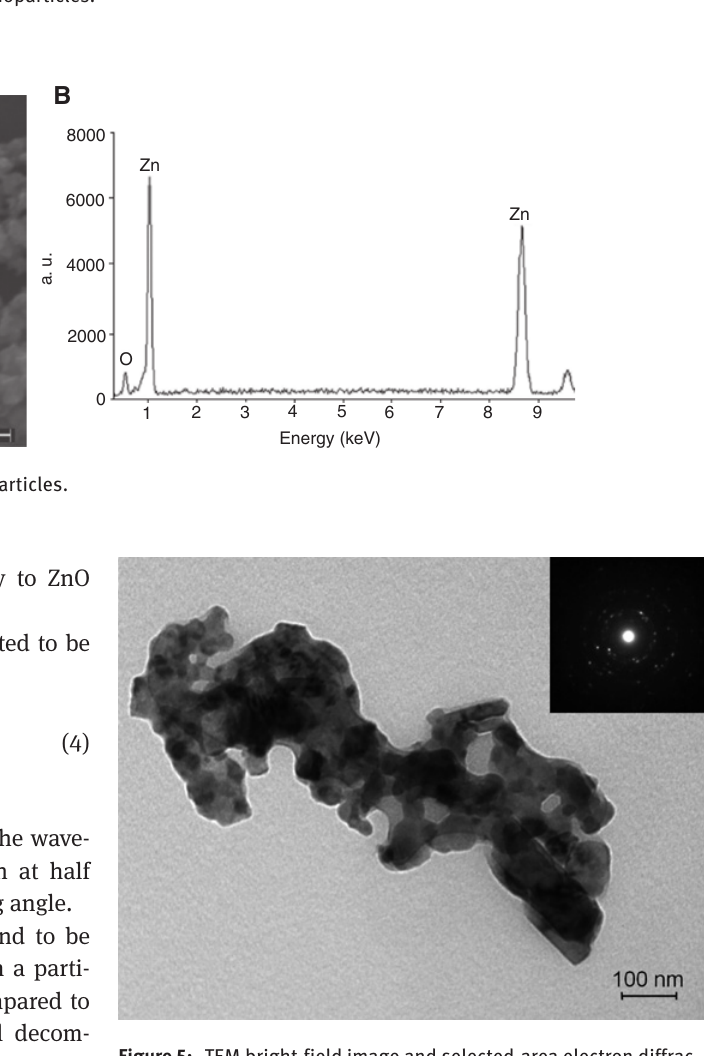
Figure 5: TEM bright-field image and selected-area electron diffrac- tion (SAED) of ZnO